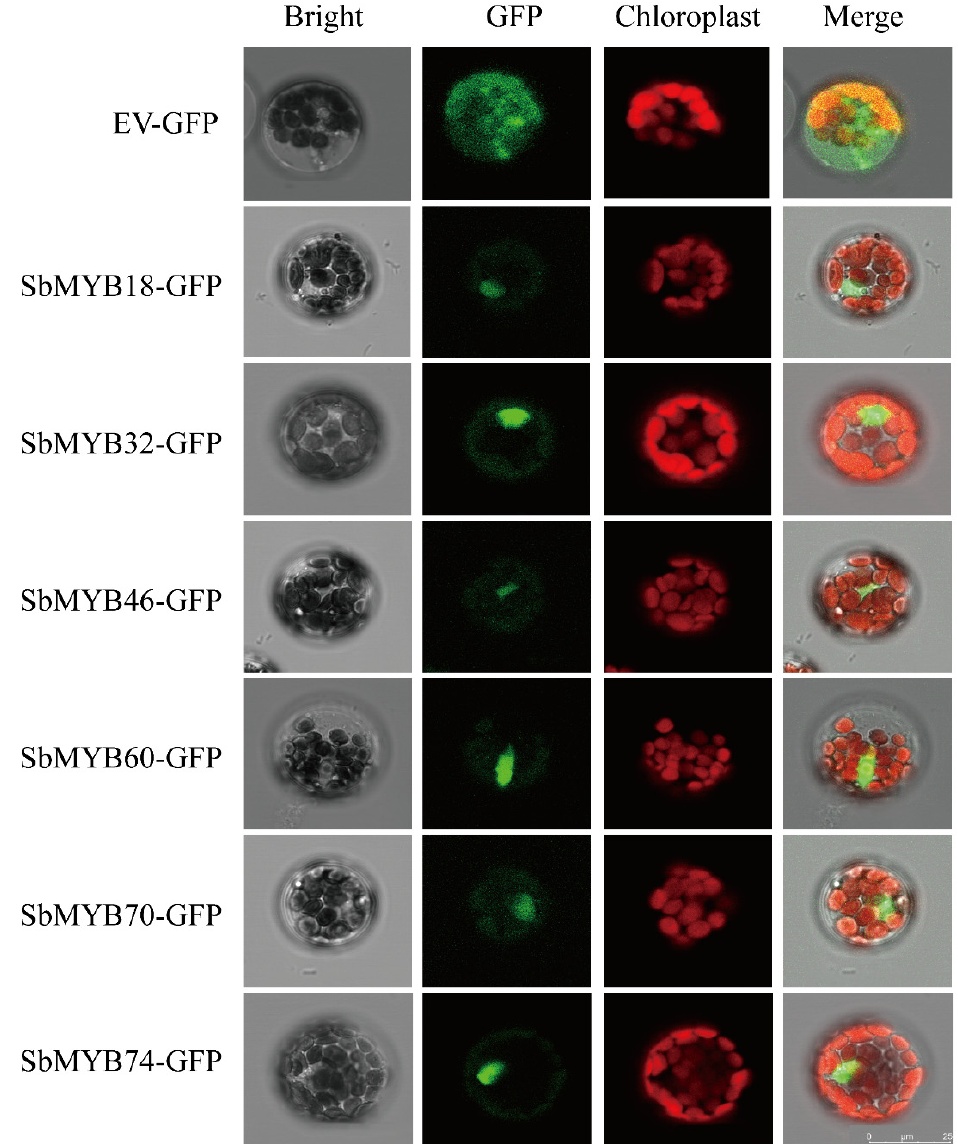
Figure 12. Subcellular location of the selected Sb MYBs ( Sb MYB18/32/46/60/70/74) in Arabidopsis mesophyll protoplasts by laser confocal microscopy, with GFP as the positive control (Scale bar: 25 µm).